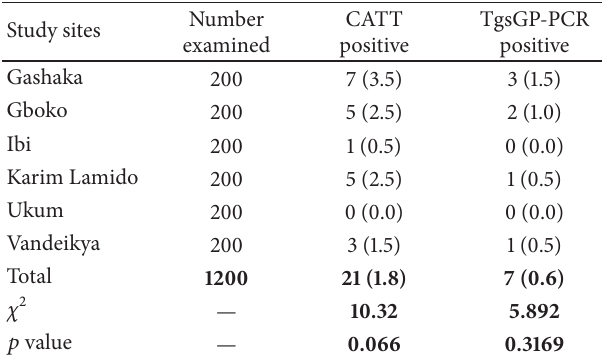
Table 1: PCR and CATT based prevalence of Trypanosoma brucei gambiense in relation to study sites.